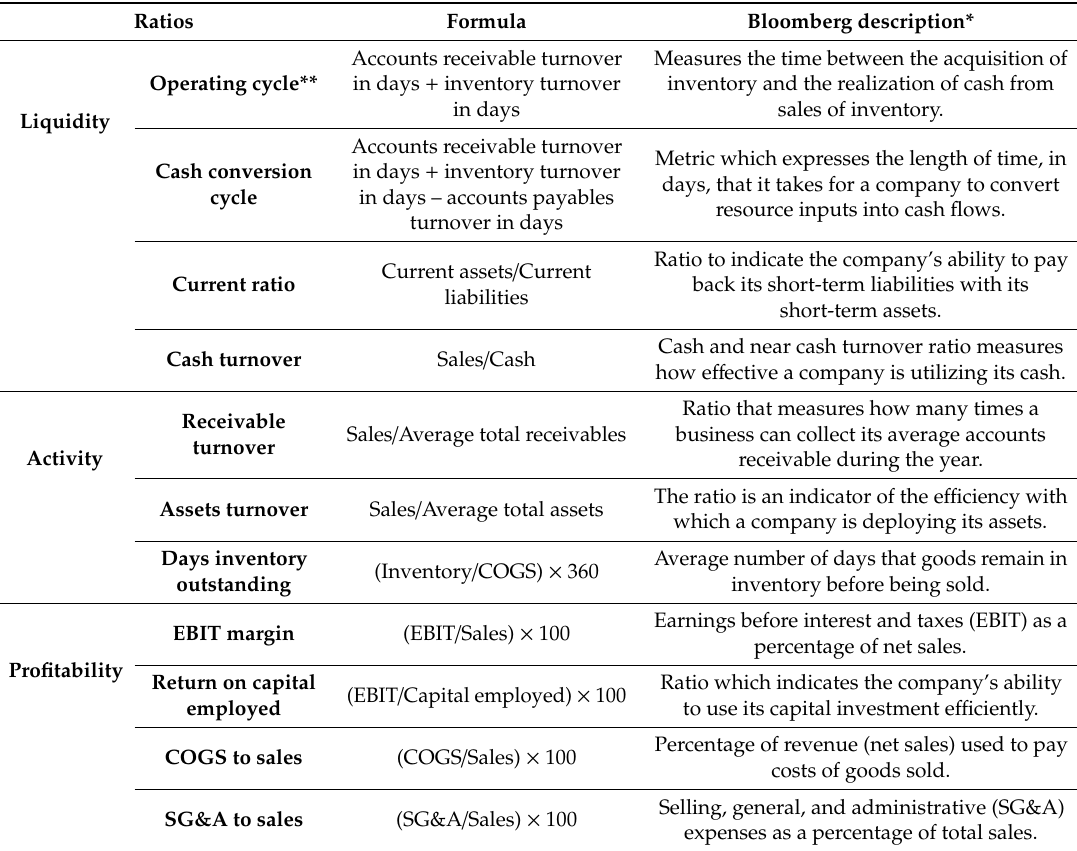
Table 2. Selected financial